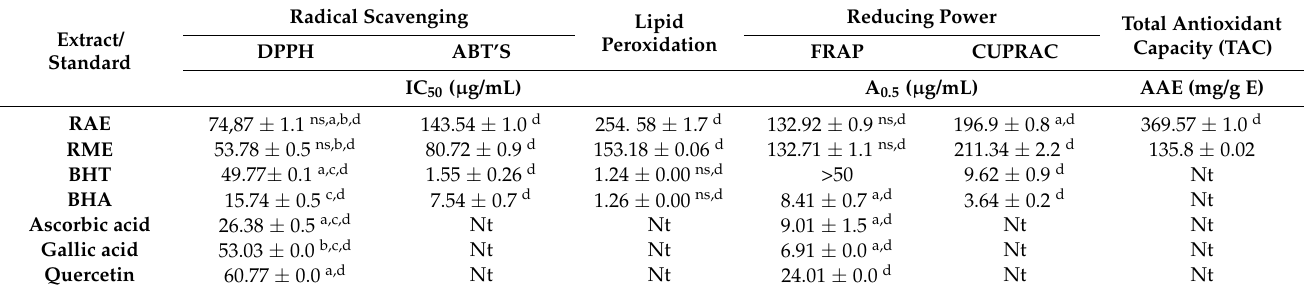
Table 2. Antioxidant activities of the polar extracts from R. tuberculata aerial